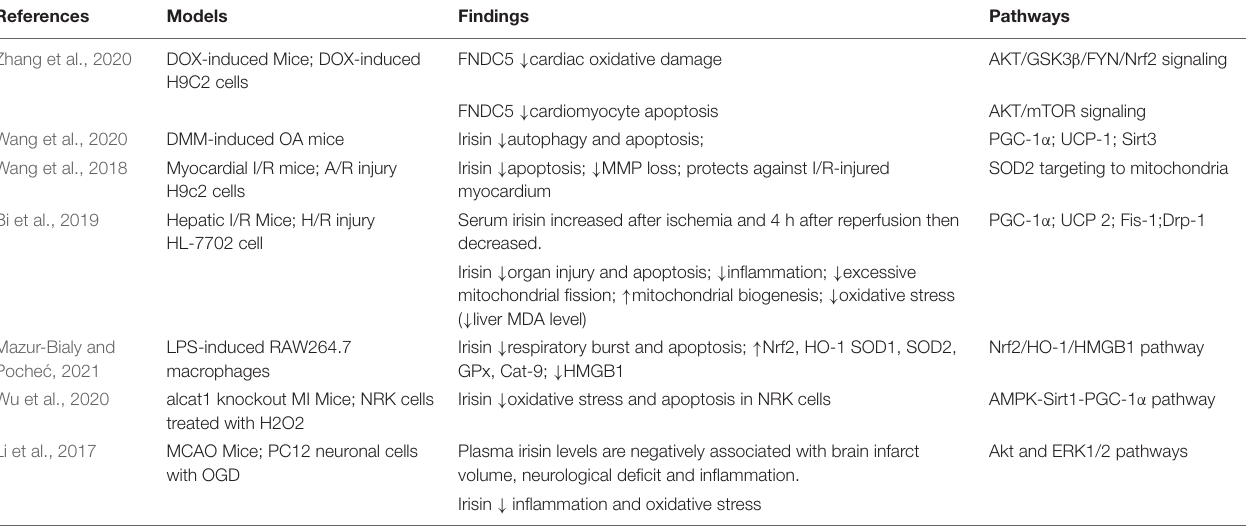
TABLE 2 | Experimental studies suggesting the roles of FNDC5/irisin in oxidative